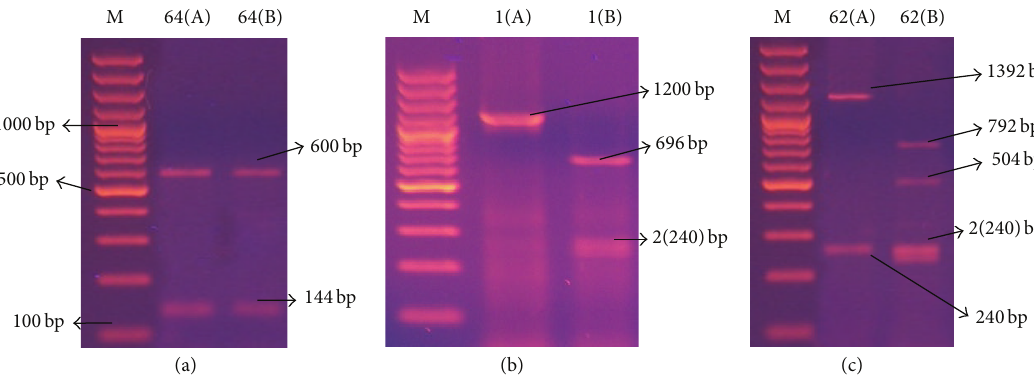
Figure 5: Representative 2% agarose gel electrophoresis of spa gene HaeII restriction enzyme digestion PCR products, where M is DNA molecular size marker (100 bp ladder). (a) isolate 64 showing 2 bands spa gene PCR products (A) that remained uncut after (B) restriction, (b) isolate 1 showing single band spa gene PCR products (A) and the corresponding 3 bands HaeII restriction digestion pattern (B), and (c) isolate 62 showing 2 bands spa gene PCR products (A) and its corresponding 4 bands HaeII restriction digestion products